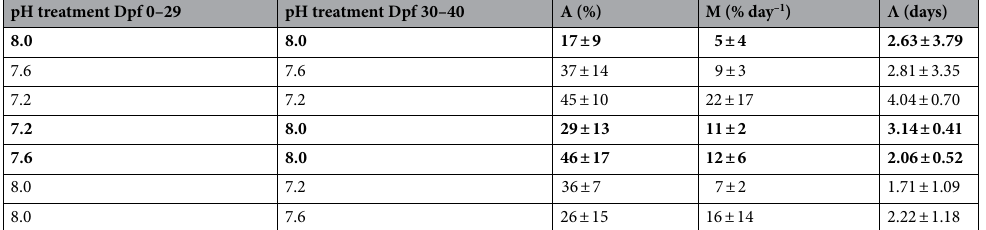
Table 1. Parameters extracted from the Gompertz model by treatment (means ± SD, n = 3 plates): maximum cumulated settlement (A; % larvae), maximum settlement rate (M; % larvae day –1 ) and initial latency period (λ; days from d 30). The three treatments in bold were significantly different from each